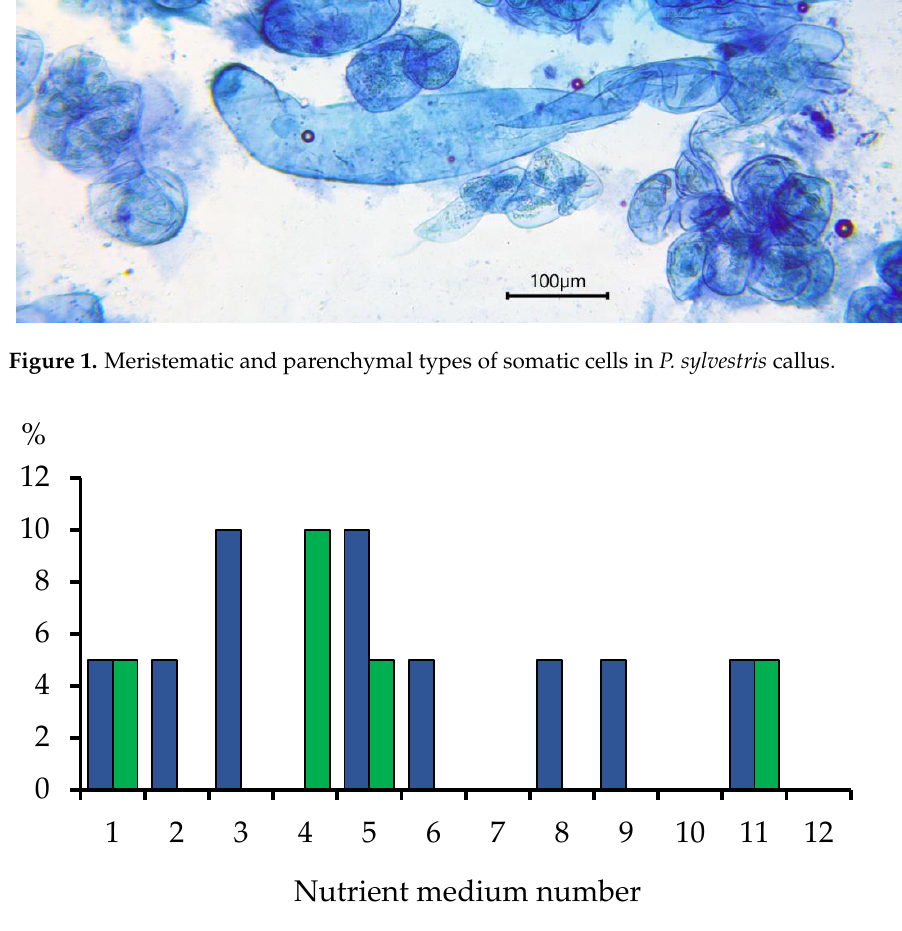
Table 3. Mean frequency of callus/plant formation from Pinus sylvestris mature seeds megagame- tophytes from different habitats on the nutrient media differed in composition and density. Event/Medium, %